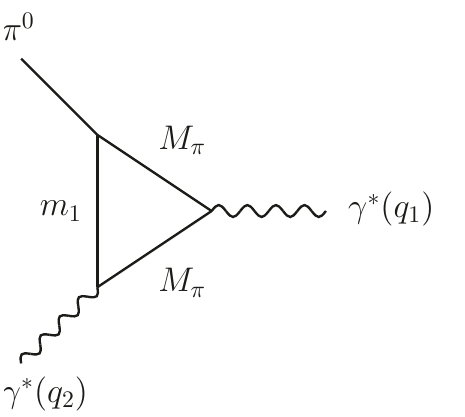
(cid:13) (cid:3) (cid:13) (cid:3) transition. For the physical case m 1 !